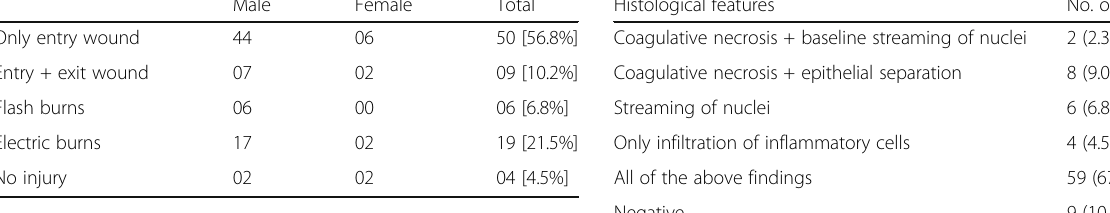
Table 9 Histological findings of contact skin in electrocution Histological